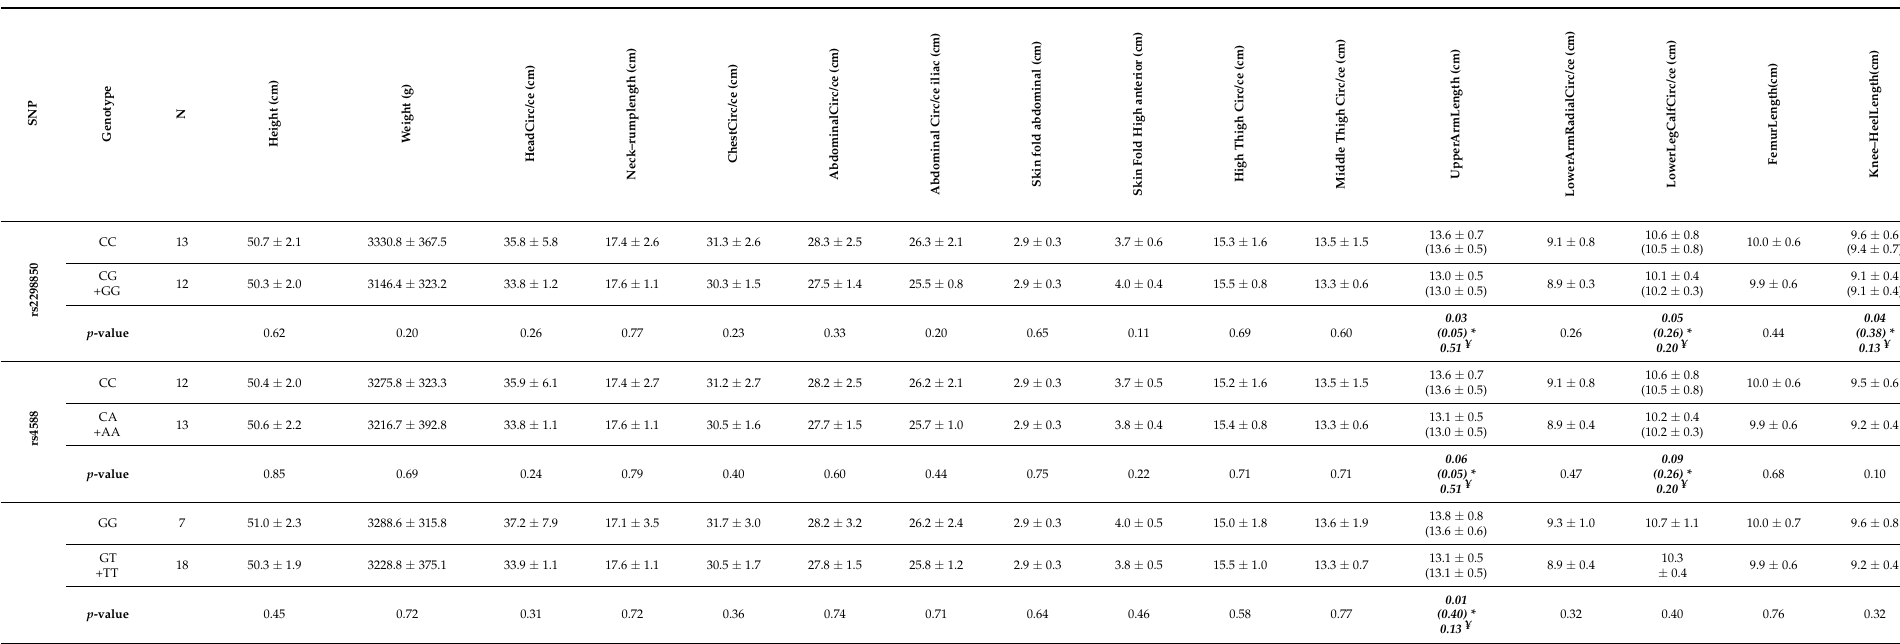
Table 5. Birth neonatal anthropometry (neonatal 25(OH)D ≤ 25 nmol/L) according to neonatal VDBP polymorphisms. If Levene’s Test for Equality of Variances p > 0.05 then Equal variances assumed Sig (2-tailed) p -values of T-Tests were given. If Levene’s Test for Equality of Variances p < 0.05 then Equal variances not assumed Sig (2-tailed) p -values of T-Tests were given. * The data and p -values adjusted for maternal height (cm), BMI pre-pregnancy (kg/m 2 ), BMI terminal (kg/m 2 ), UVB exposure, and weeks of gestation by One-way analysis of covariance (ANCOVA) Numbers in italics are after adjustments. ¥ Observed power